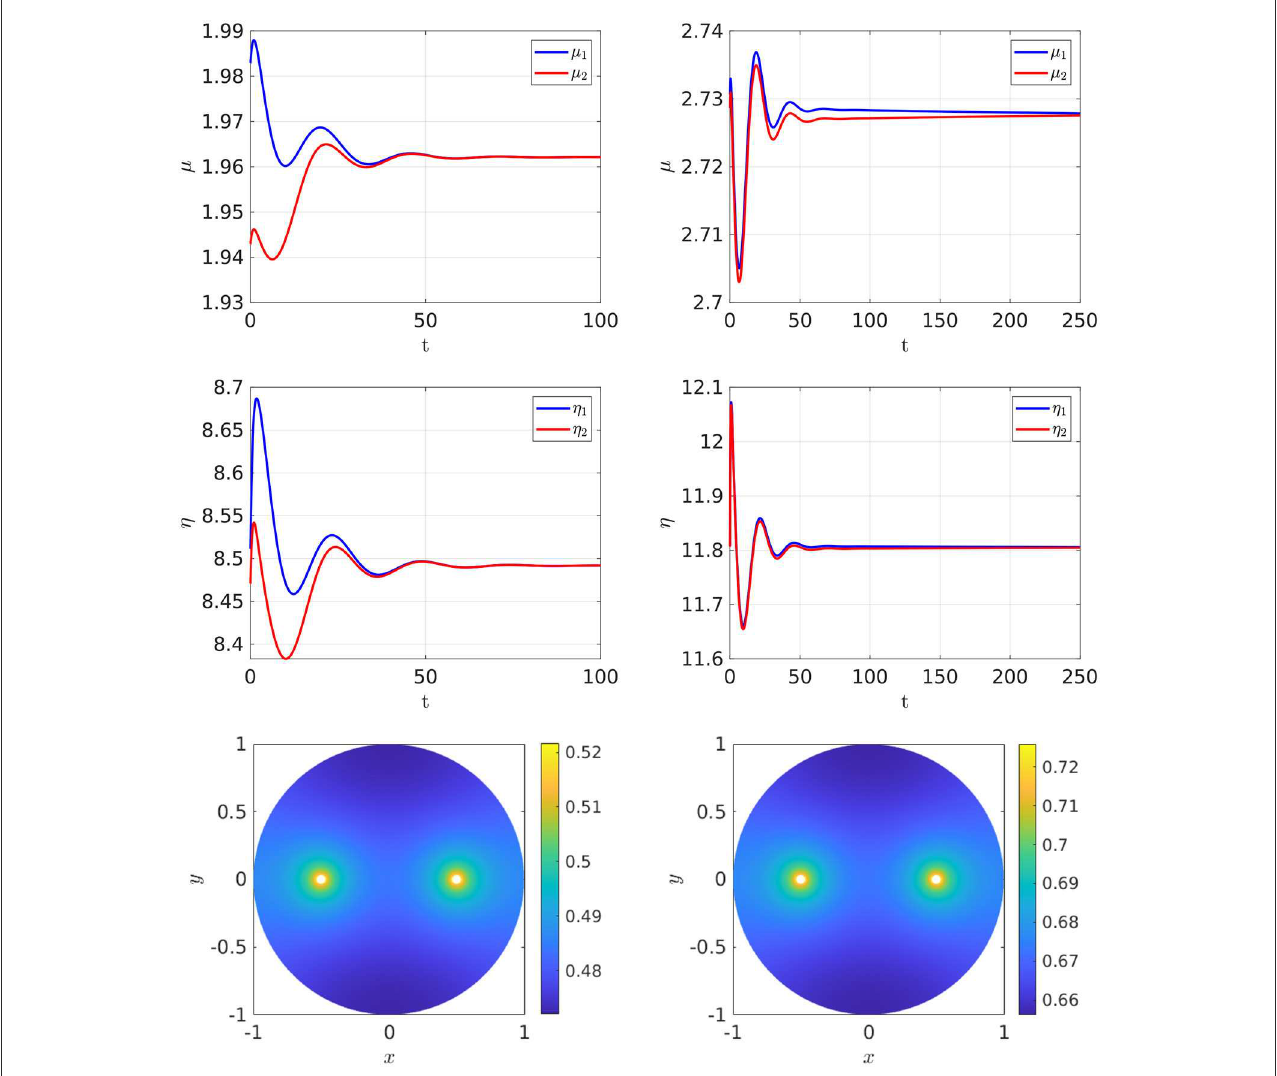
FIGURE6 Full numerical simulation results of Equation (2.3) with FlexPDE [50] for GM kinetics (Equation 4.3). Left: for an initial condition near the symmetric branch we observe convergence to the symmetric branch when ρ 4, which is before the hysteresis region bounded by the fold point ρ s 6.27945 and the = ≈ subcritical pitchfork point ρ p 7.70971. Right: convergence to the symmetric branch for ρ 7.2, which lies on the range ρ s < ρ < ρ p , when starting near ≈ = the symmetric branch. The bottom panels show the concentration of u . Parameters: D